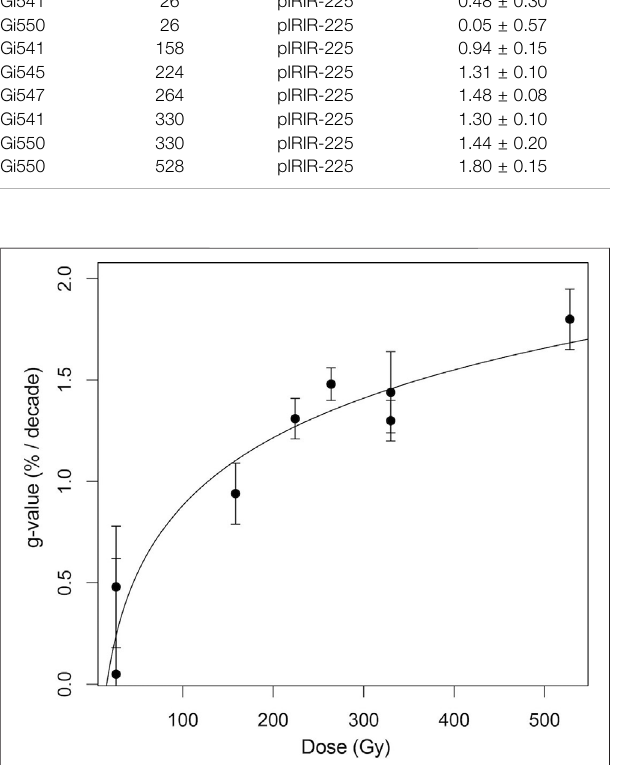
FIGURE 4 | Measured fading rates versus given dose in the fading test, and the potential logarithmic relation between the